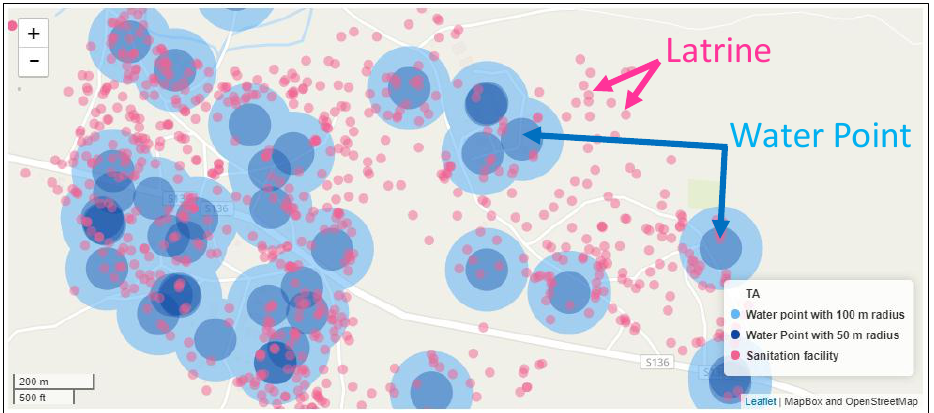
Figure 5. Co-location of pit latrines and rural water supplies has increased the risk of contamination and disease, resulting in an expectation that both the water resource (groundwater) and water point (borehole) will have reduced life-spans due to major contamination of groundwater (from the Climate Justice Fund Water Futures Programme (CJF) mWater data console).